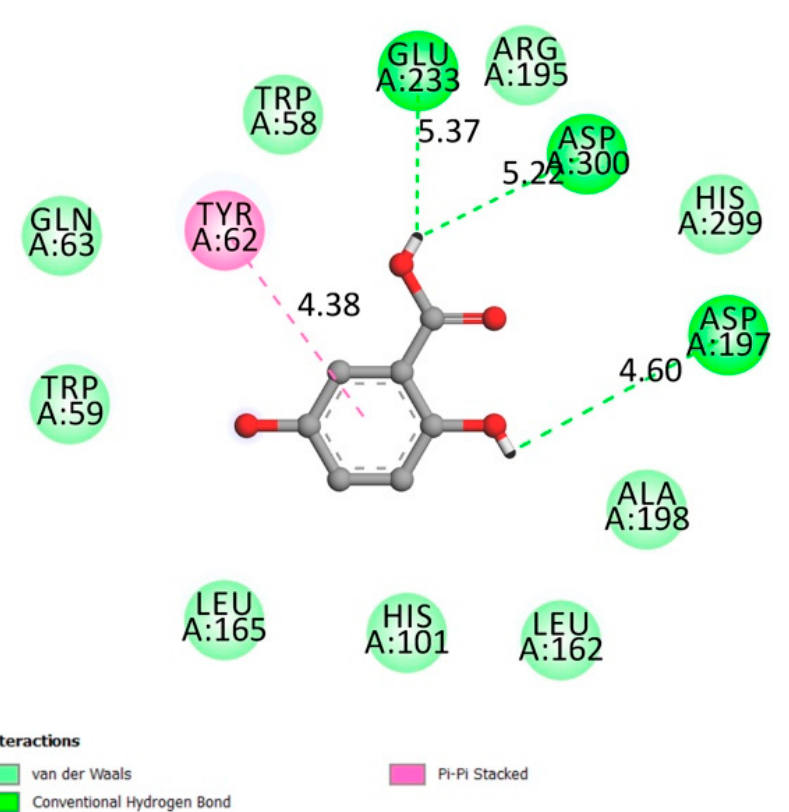
Figure 3. Two-dimensional scheme of the GA interactions with α -amylase receptor.